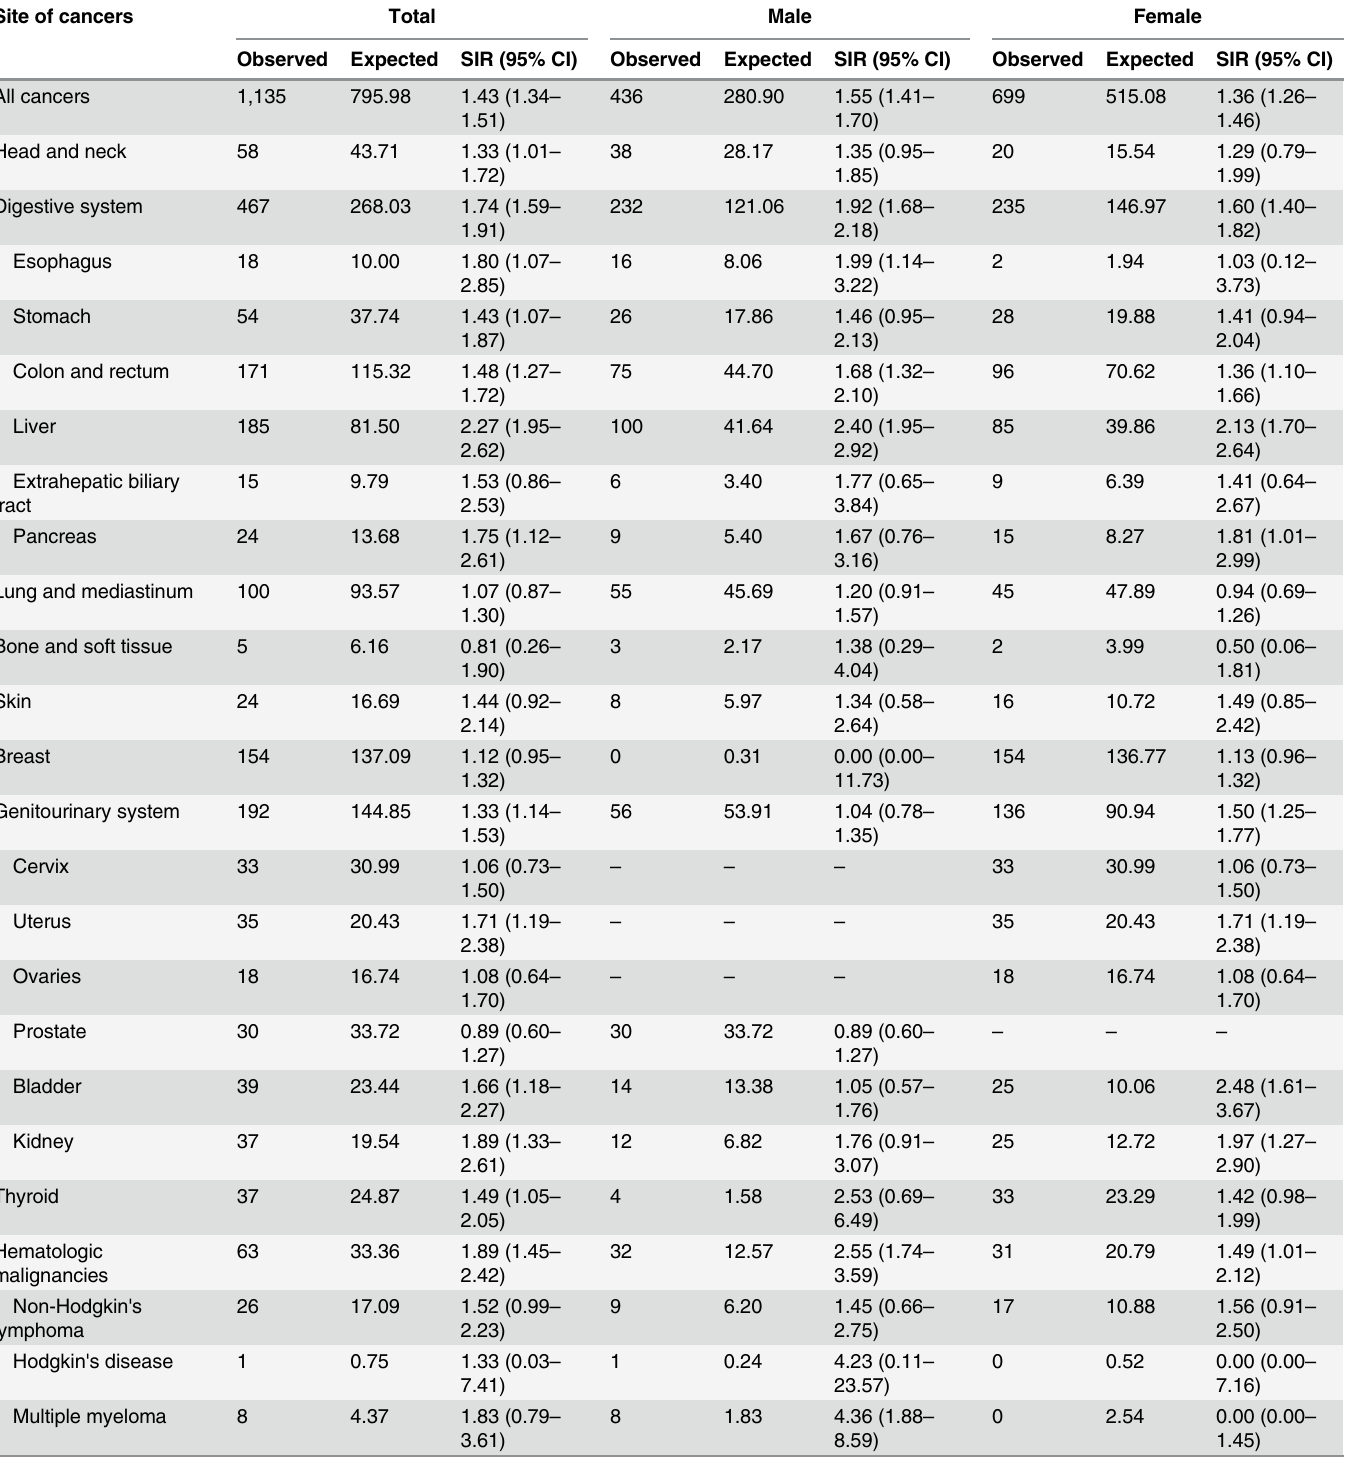
Table 3. SIRs of speci fi c cancer types among patients with iron de fi ciency anemia (IDA) after excluding the fi rst year of observation post